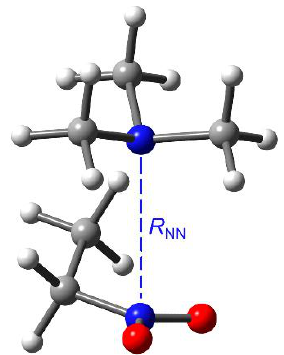
Figure 10. The nitromethane···trimethylamine pnictogen complex [145].